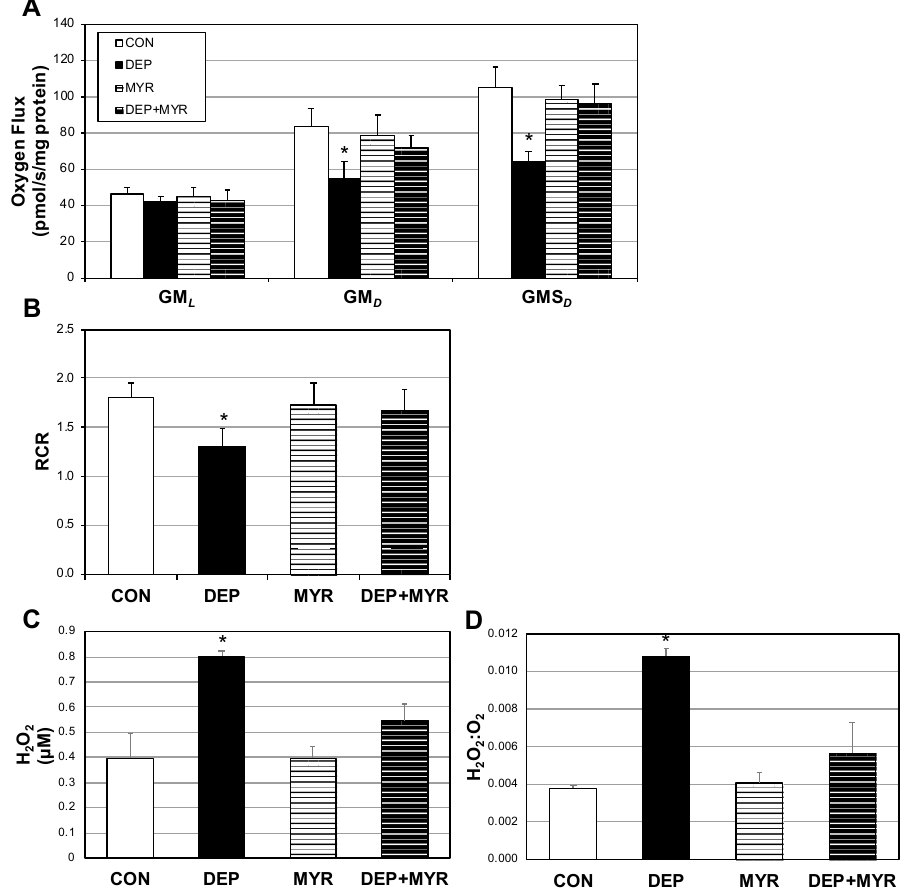
Figure 5. Primary alveolar macrophage mitochondria negatively respond to diesel exhaust particles (DEP). Primary alveolar macrophages were plated and treated control media (CON), DEP, myriocin (MYR), or DEP + MYR for 12 h. Following treatment, mitochondrial respiration ( A ) and respiratory control ratio (RCR) ( B ) were quantified. O 2 consumption was determined according to the protocol outlined in materials and methods. GM L : glutamate (10 mM) + malate (2 mM); GM P : + ADP (2.5 mM); GMS P : + succinate (10 mM); and + antimycin A (2.5 µ M; not shown) as baseline. H 2 O 2 levels ( C ) and the H 2 O 2 :O 2 ratio ( D ) were also measured n = 8. * p < 0.05; DEP vs. other conditions.